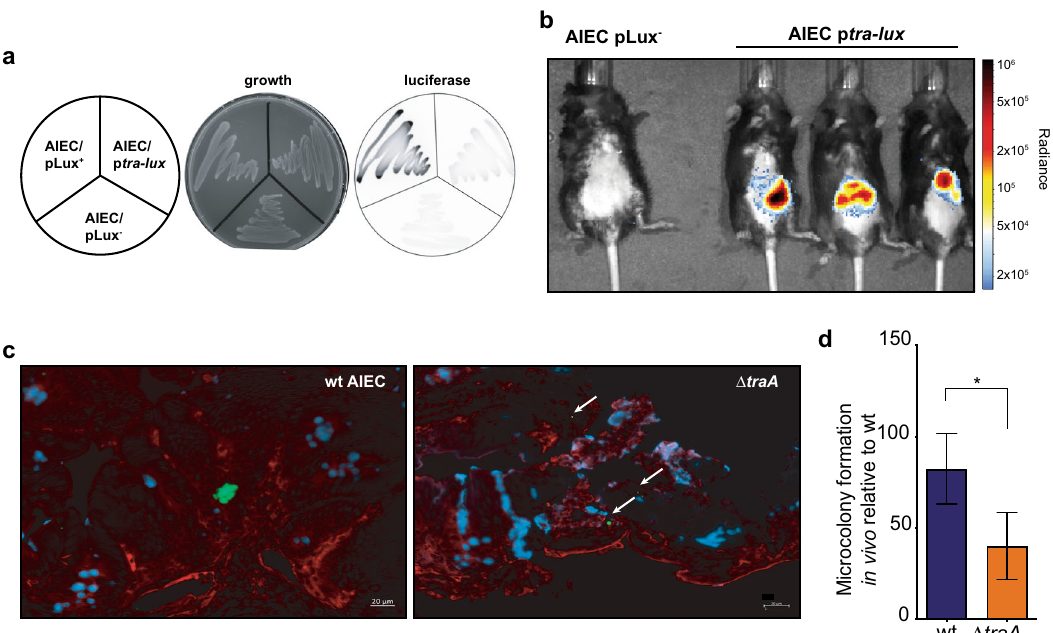
Fig. 5 The host intestinal environment activates T4SS and mediates AIEC aggregation. a Minimal expression of tra-lux transcriptional fusion in vitro. b T4SS is upregulated in the host environment. Representative whole-body images of mice infected with AIEC expressing tra - lux transcriptional fusion in the gut; n = 3 biologically independent replicates. Image is representative of two independent experiments. c Immuno fl uorescence staining of ceca from infected mice. AIEC (green, white arrows), mucin (blue), and actin cytoskeleton of intestinal cells (red); n = 3 biologically independent replicates and representative of two independent experiments. d AIEC microcolonies were quanti fi ed using 35 fi elds of view obtained from three biological replicates per strain. Presented is the mean ± SEM. Groups were compared using two-tailed Mann – Whitney U test, P = 0.0136; n = 3 biologically independent replicates and representative of two independent